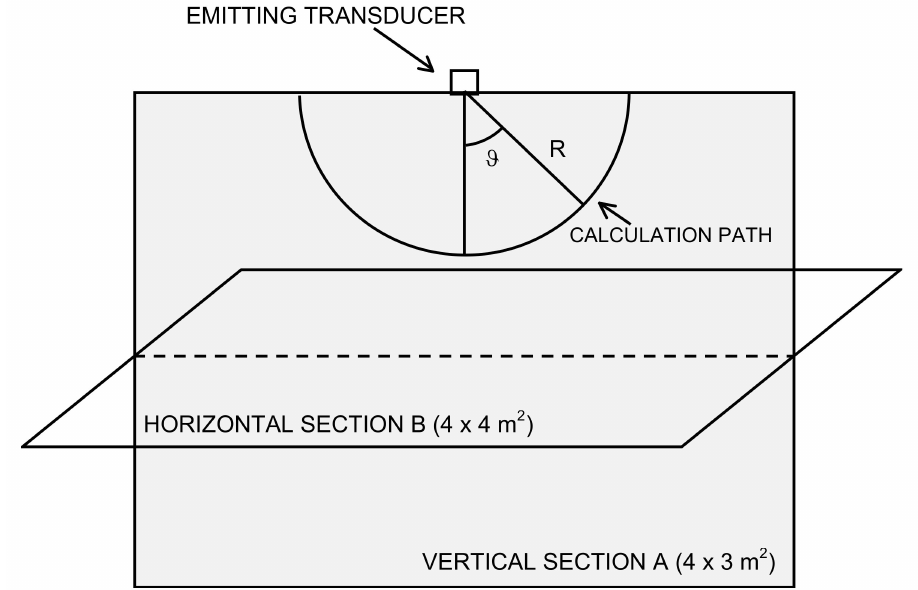
Figure 1. Simulation setup: the calculation path of the cross-correlation results shown in Figures 3–5; the vertical section A of the typical 4 m × 4 m × 3 m room along which the results displayed in Figure 6 are computed; the horizontal section B where the results displayed in Figure 7 are computed.